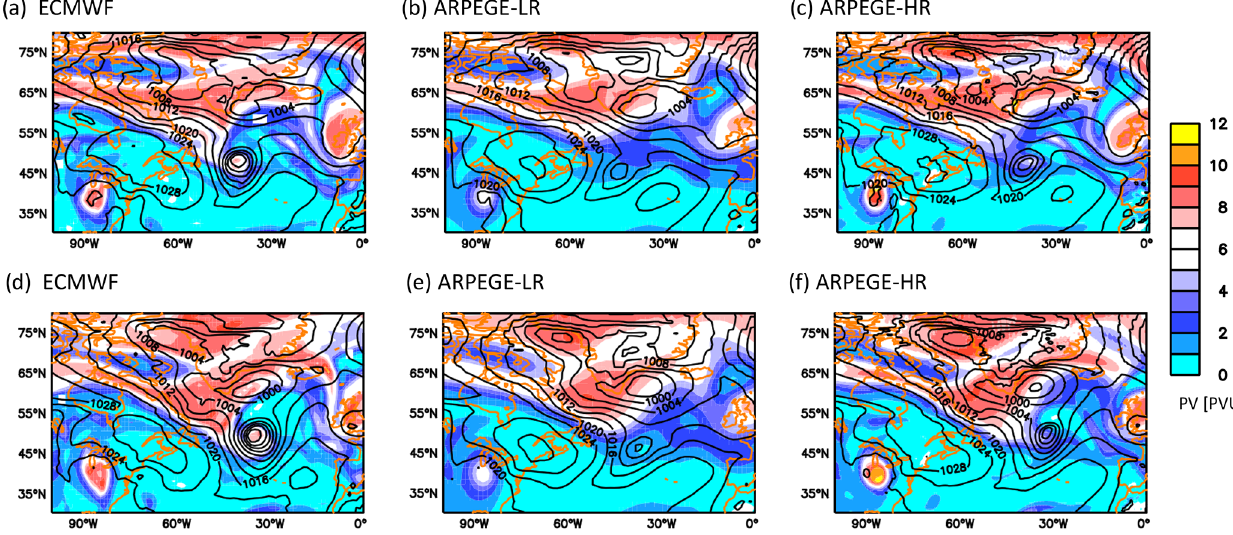
Figure 8. The 250hPa PV (shaded) and mean sea level pressure (contoured) during the maximum deepening phase of the Stalactite cyclone. (a–c) 00:00UTC 1 October 2016 and (d–f) 12:00UTC 1 October 2016. (a, d) ECMWF analysis, (b, e) ARPEGE-LR hindcast, and (c, f) ARPEGE-HR hindcast. All hindcasts were initiated at 00:00UTC 29 September 2016, and the colour scale applies to all plots. LMDZ-LR(- HR) plots at the same time are shown in Fig. S4.